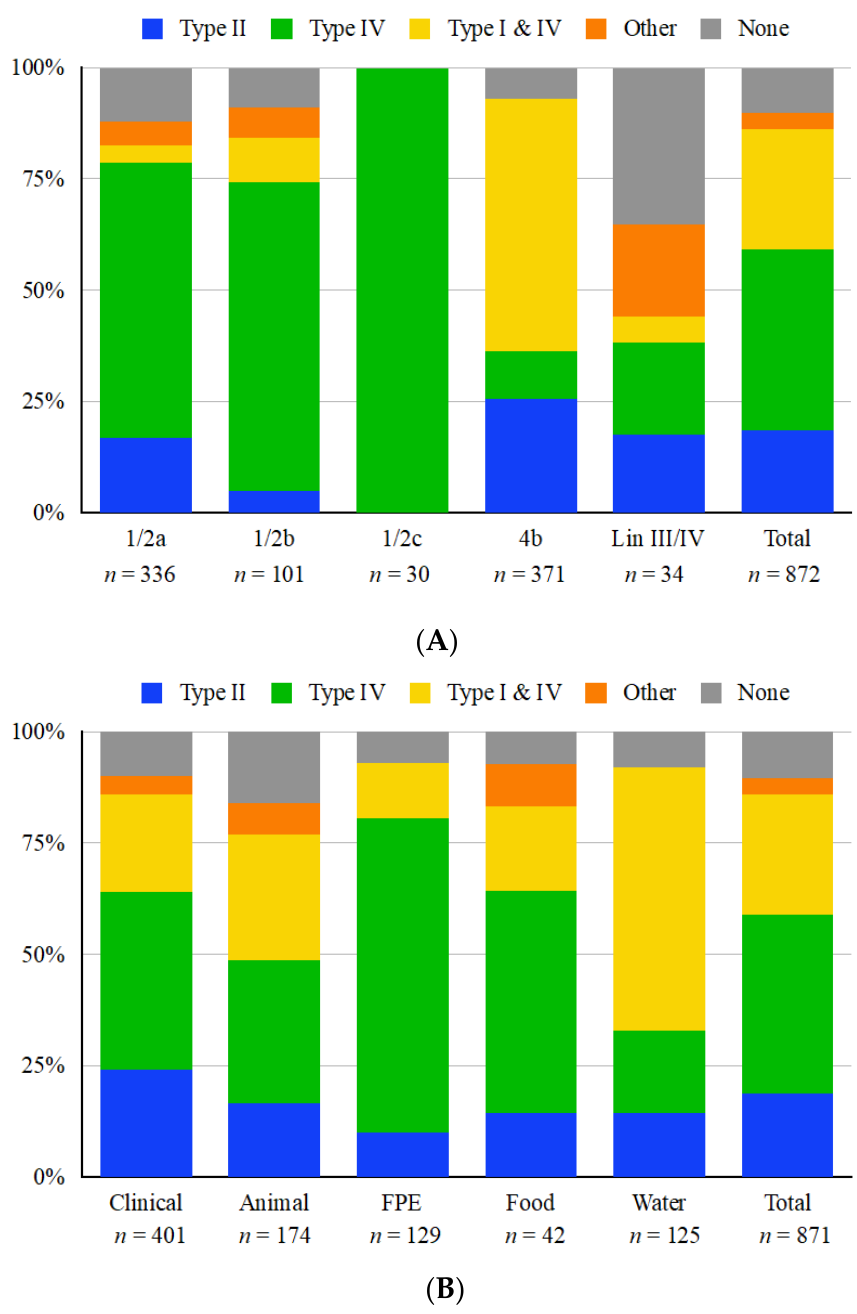
Figure 2. Distribution of restriction modification systems harbored in the immigration control re-